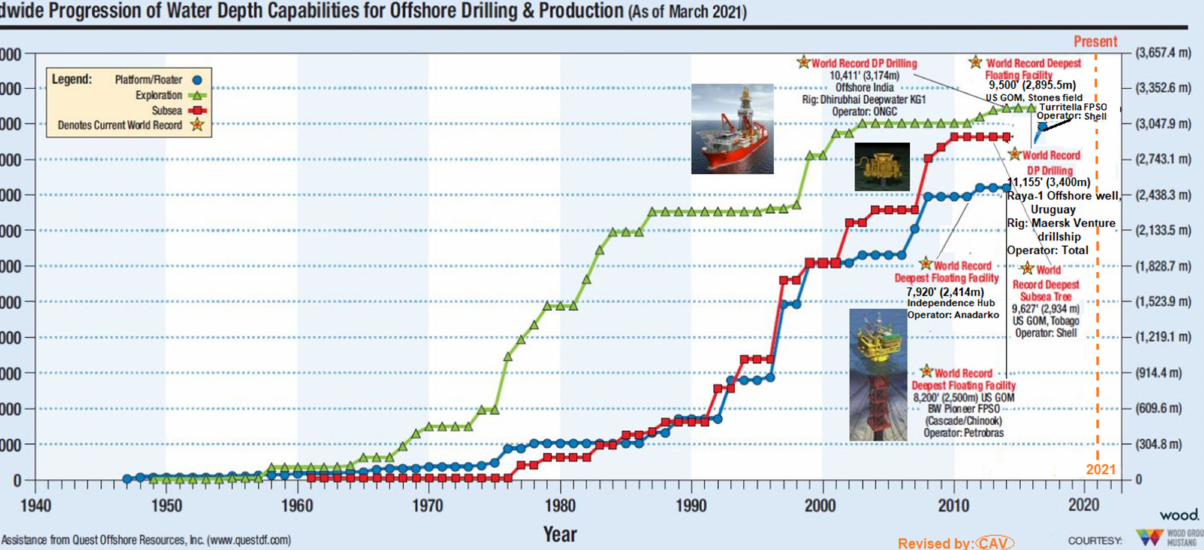
Figure A3. Worldwide progression of water depth capabilities for offshore drilling and production (Courtesy: Wood; Revised by C.V.A.).